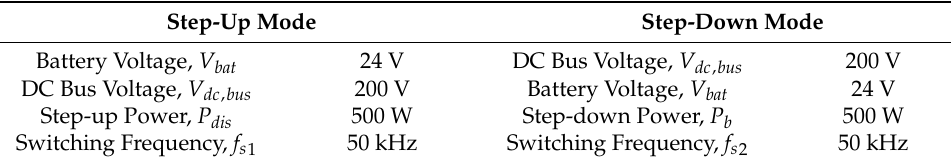
Figure 14. Block diagram of the experimental system for bidirectional power flow control. Table 1. Specifications of the experimental system.